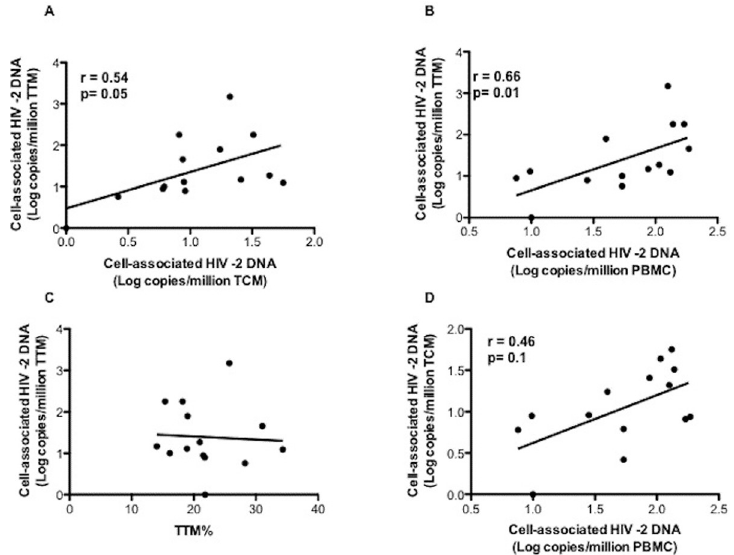
Fig 3. Relationship between cell-associated HIV-2 DNA in transitional memory T cells (TTM; CD45RA-CCR7-CD27 +) and A) cell-associated HIV-2 DNA in central-memory (TCM; CD45RA-CCR7+CD27+) and B) cell-associated HIV-2 DNA in peripheral blood mononuclear cells (PBMCs) and C) transitional memory T cells (TTM; CD45RA-CCR7-CD27+) numbers in the peripheral blood. D) Relationship between cell-associated HIV-2 DNA in central-memory (TCM; CD45RA-CCR7+CD27+) and in in peripheral blood mononuclear cells (PBMCs). Fourteen HIV-2 infected subjects are represented. Each symbol represents a subject. Correlations were determined with Spearman’s rank test.